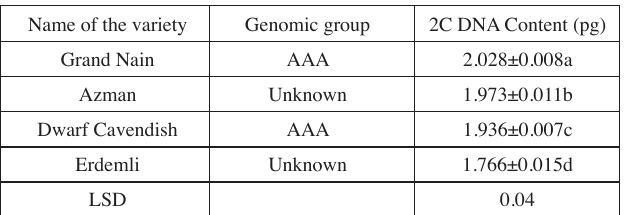
Tab. 4: Nuclear DNA content of 4 banana cultivars based on internal stan- dards of